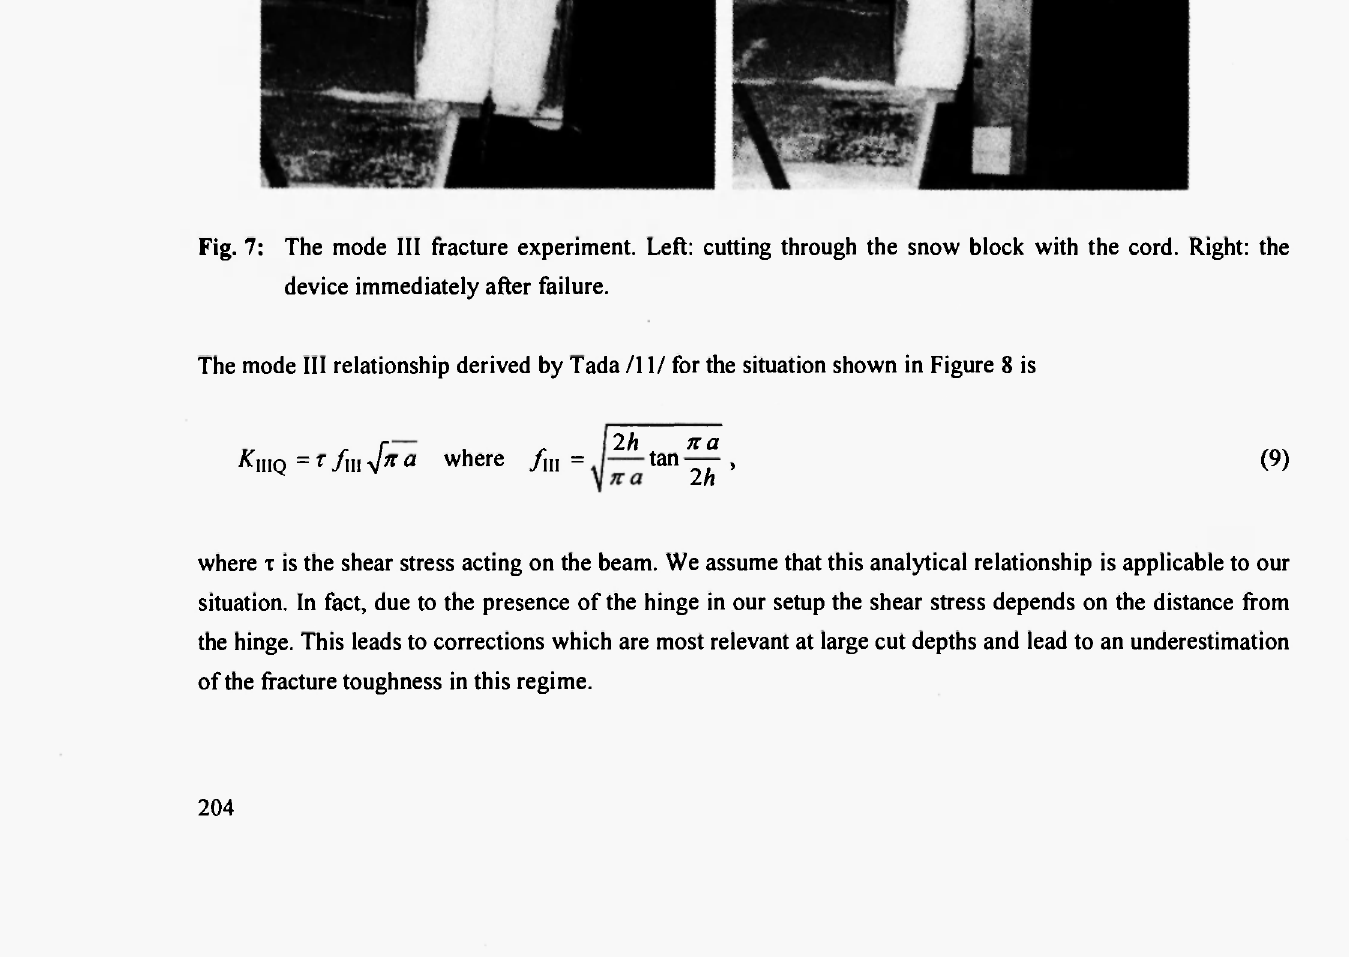
Fig. 7: The mode III fracture experiment. Left: cutting through the snow block with the cord. Right: the device immediately after